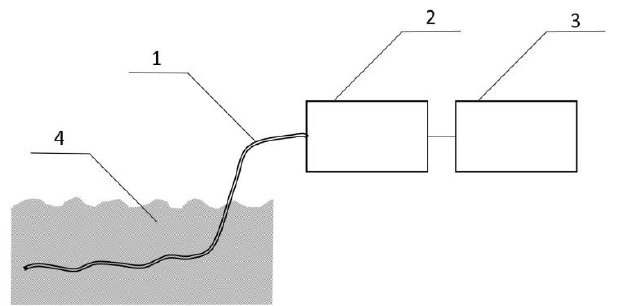
Figure 6. Capillary PP/PSi tubing (1) with one end welded is immersed in water BMK solution mimicking sewage drainage (4). The gas sample is collected with a small air pump (2) connected to the DT IMS analyzer (3).